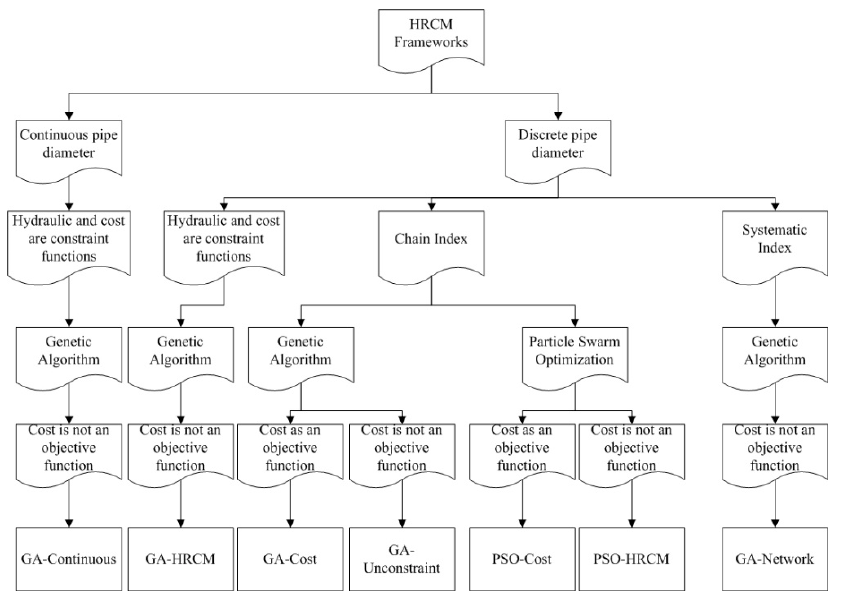
Figure 2. Flowchart of different optimization algorithms.